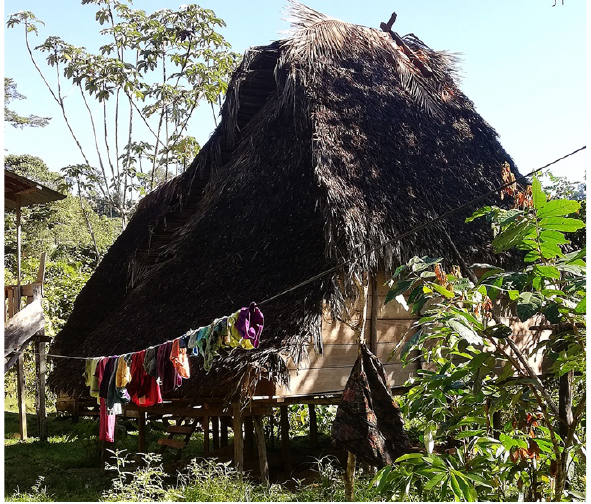
Figure 14. Ngäbe cobijo at Quebrada